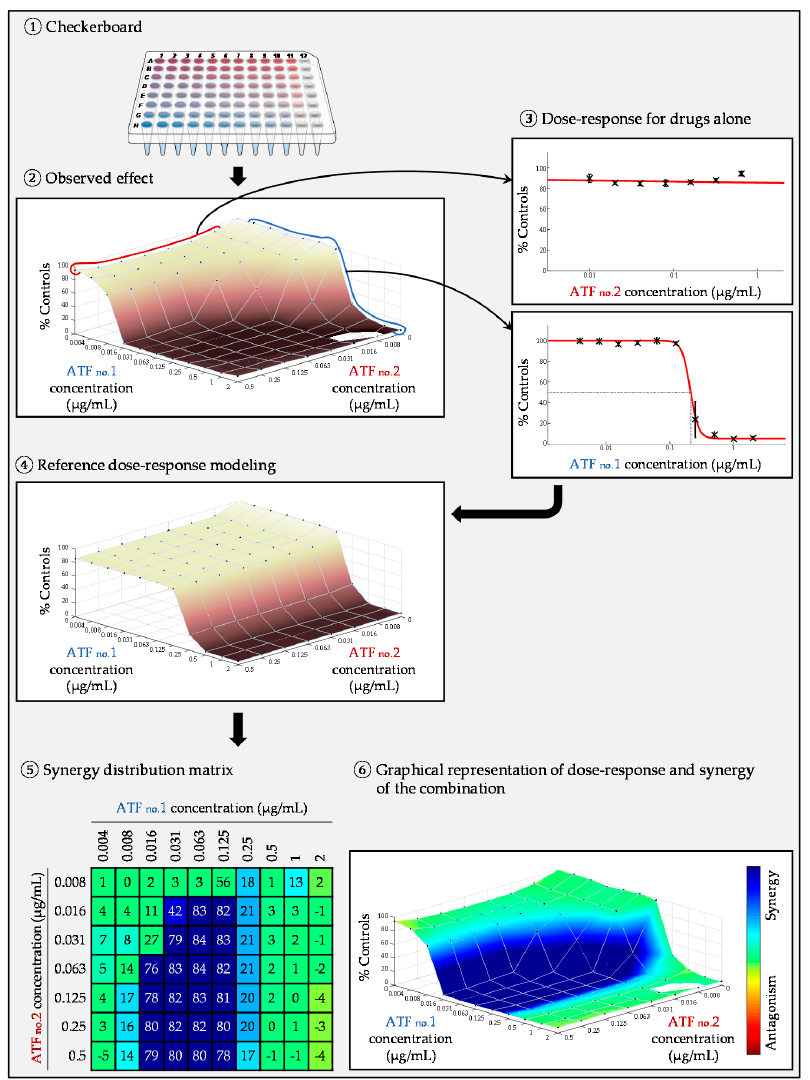
Figure 5: Example of a response-surface analysis for an in vitro antifungal combination experiment. Graphics were generated by the Combenefit software [96].